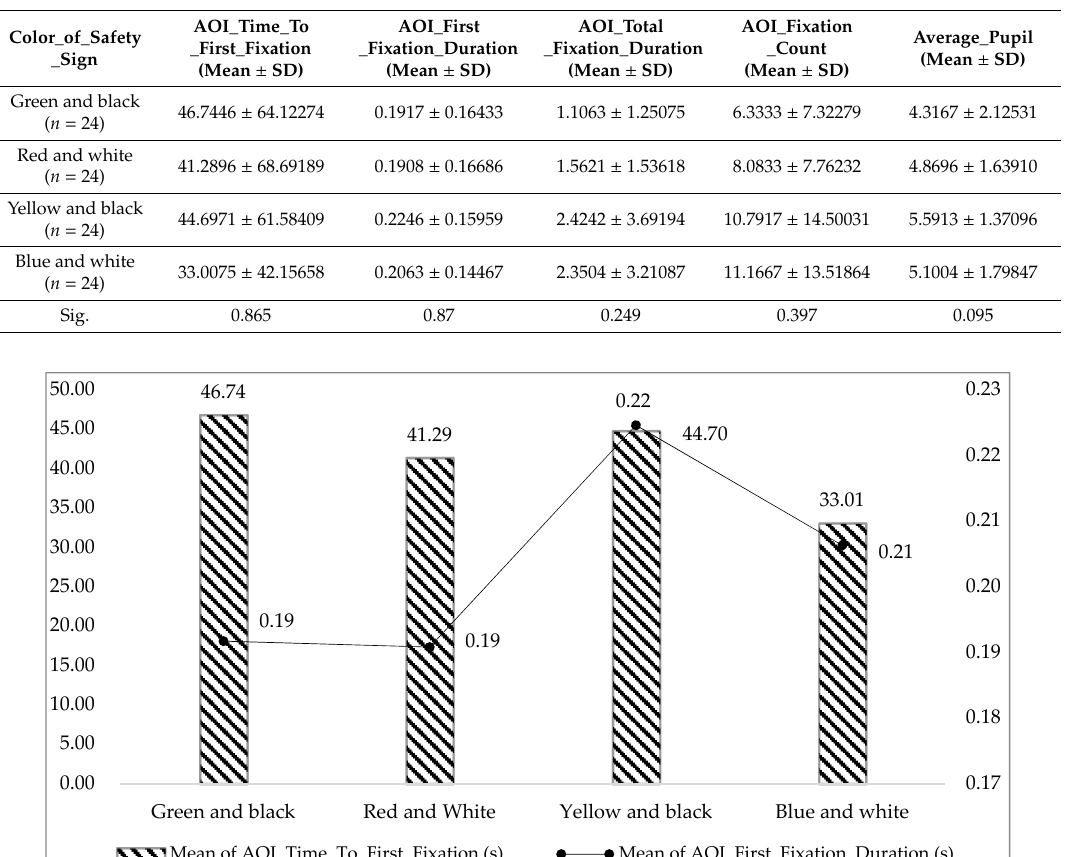
Table 5. One-Way ANOVA of participants’ eye-tracking indicators (Grouping Variable: Color_of_safety_sign).